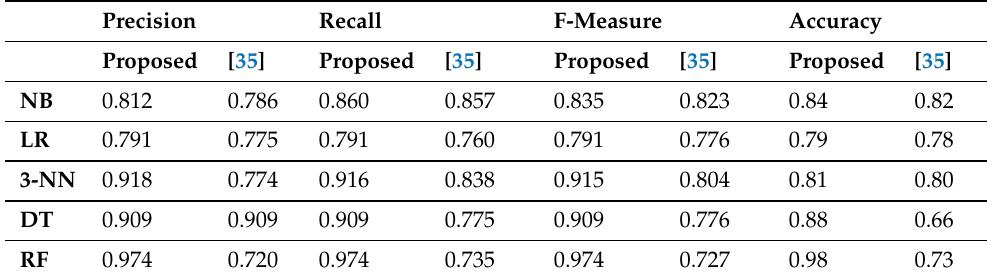
Table 3. Comparison of ML models